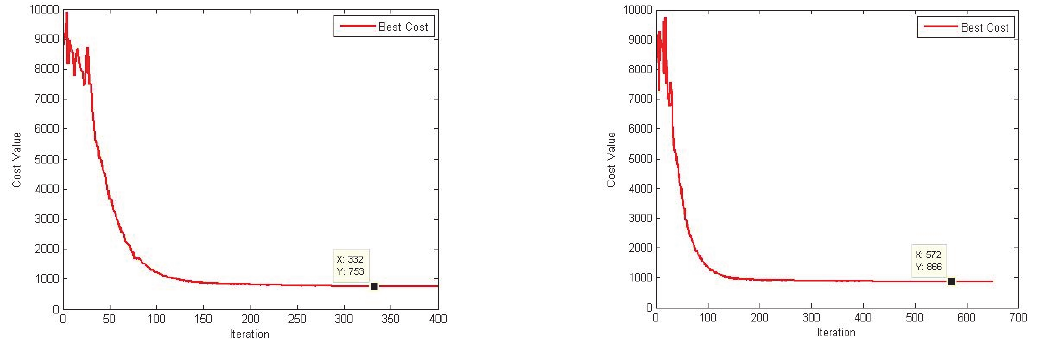
Fig. 8. Solution of two-objective problem scp 4.1 Fig. 9. Solution of two-objective problem scp 4.2